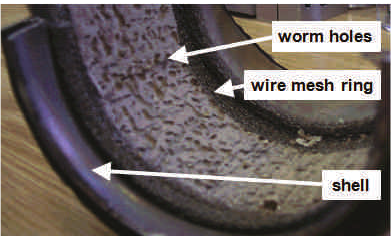
Fig. 6. Worm-holing effect by solid non fibrous material in the mat [4] Proper support mat mounting and compression of it in the housing is very significant in case of intumescent mats. When the intumescent mat is compressed not enough the so called “worm-holing” effect (Fig. 6) can appear.